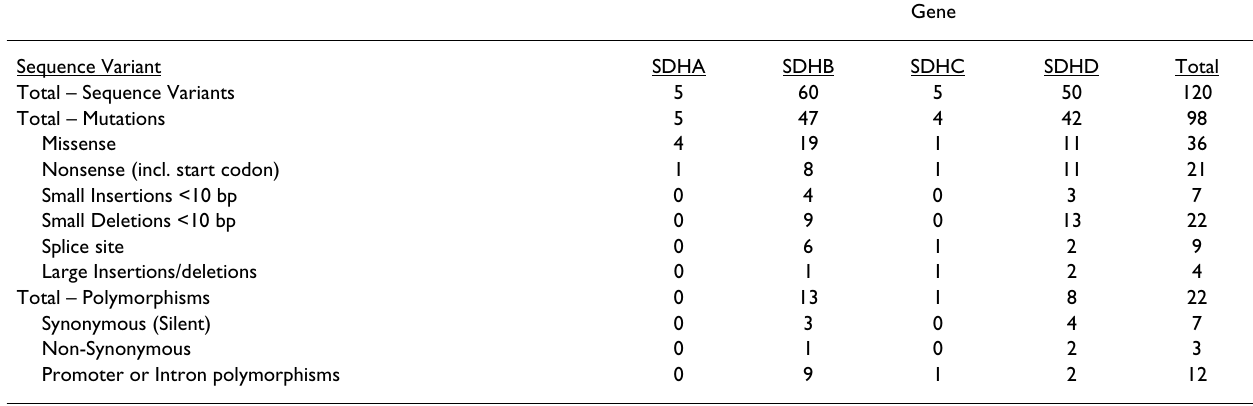
Table 1: A summary of all allelic variants in the SDH mutation database as of September